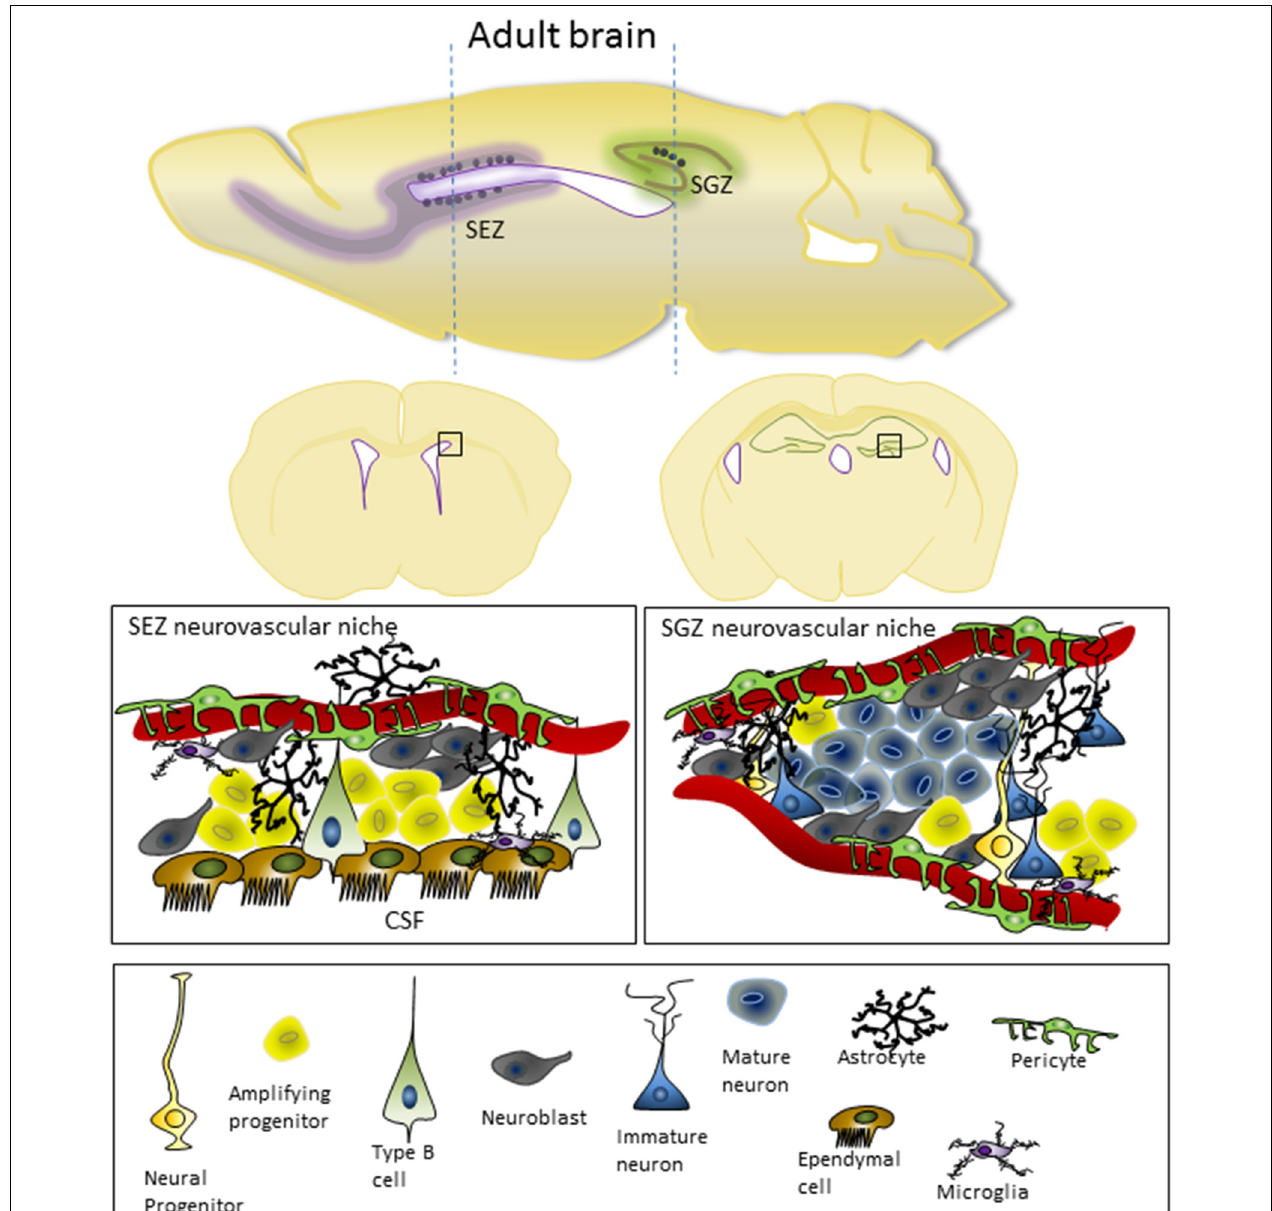
FIGURE 2 | Adult cortex in the mouse, shown from both sagittal and coronal views, indicating the location of the SEZ and SGZ neurovascular niches. The microstructure and cellular component of the SEZ and SGZ are shown underneath. In the SEZ, progenitor cells are in close contact with the